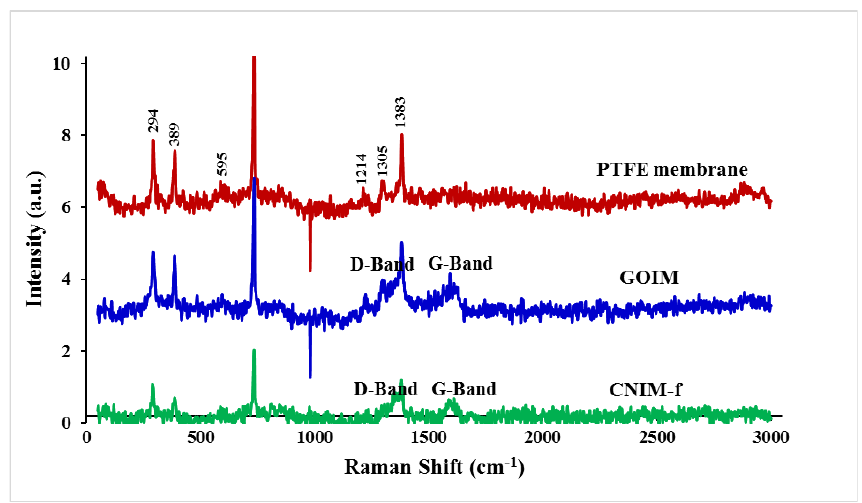
Figure 2. Scanning electron microscopy (SEM) images of ( a ) the feed side of original PTFE membrane, ( b ) the permeate side of original PTFE membrane, ( c ) graphene oxide-immobilized membranes (GOIM) and ( d ) functionalized carbon nanotube-immobilized membranes (CNIM-f).